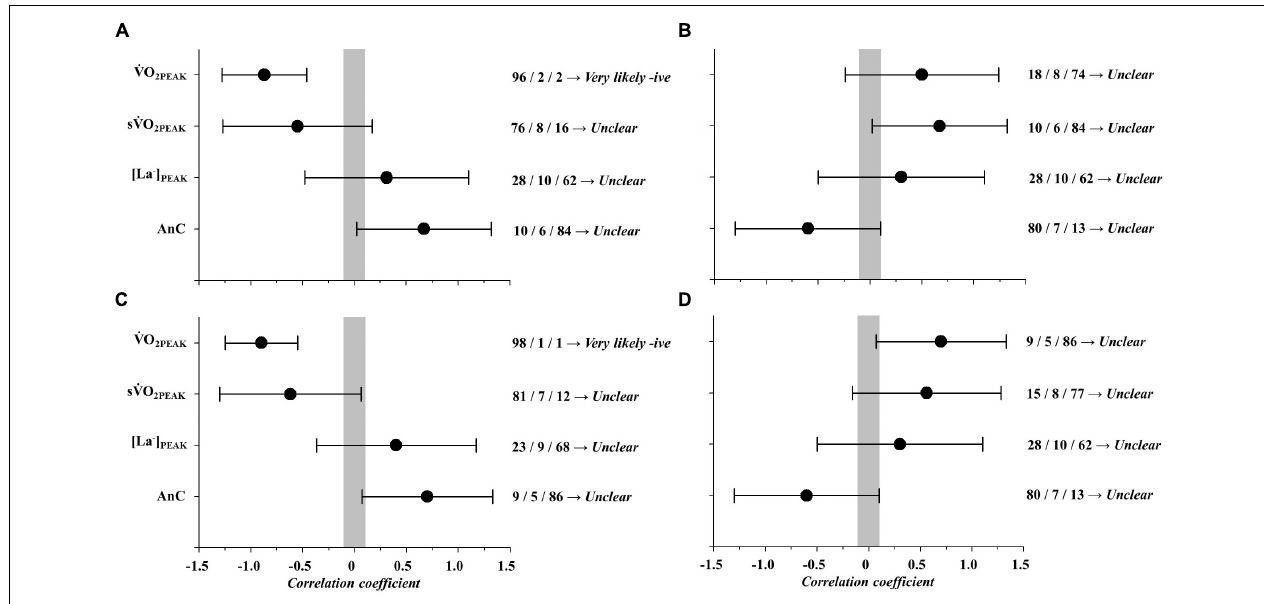
FIGURE 2 | Magnitude-based inference correlations between laboratory parameters (LaB) and game technical performance (GTP). ˙VO 2PEAK , peak oxygen consumption; s˙VO 2PEAK , speed correspondent to ˙VO 2PEAK ; [La − ] PEAK , peak blood lactate concentrations; AnC, anaerobic contribution. (A) Correlation between LaB and throws; (B) Correlation between LaB and defenses; (C) Correlation between LaB and recoveries; (D) Correlation between LaB and density.